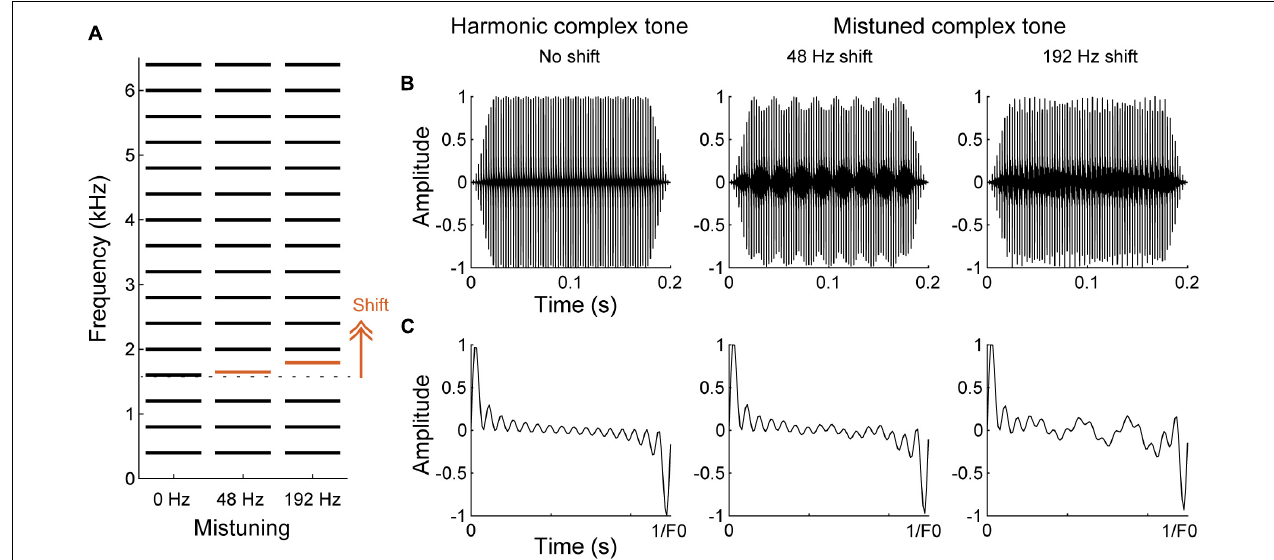
FIGURE 5 | Spectral and temporal cues in harmonic and mistuned complex tones. (A) Schematic of spectral structures of harmonic and mistuned complex tones comprised a F0 of 400 Hz with 16 harmonics. 4th harmonic (red) is shifted to higher frequencies for the mistuned complex tones by 48 or 192 Hz. (B,C) The waveforms of the complex tones shown in A for the overall tone duration (B) and for one cycle of the period of the harmonic complex tone (C) . Due to the mistuned harmonic, additional temporal fluctuations emerge for the mistuned complex